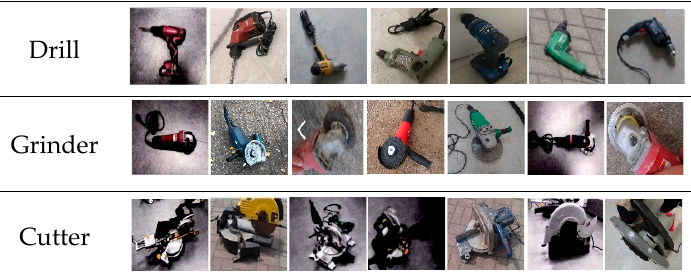
Figure 4. Examples of small and medium-sized indoor construction tools dataset [9]. (Reproduced with permission from Lee et al., KSCE Journal of Civil Engineering; published by Korean Society of Civil Engineers, 2023)